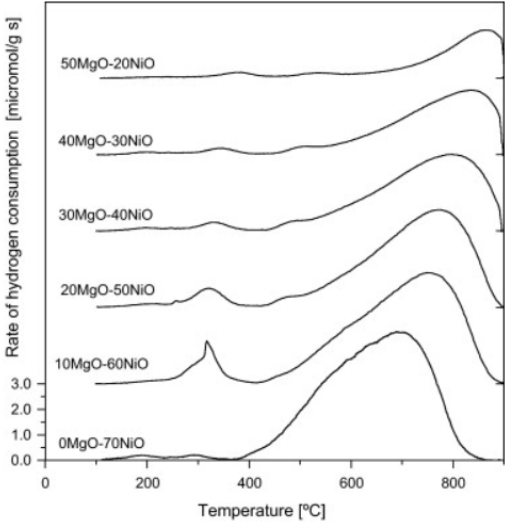
Figure 3. TPR of Ni-MgO samples with different loading of MgO. Reprinted with permission from [64], copyright 2011, Elsevier.